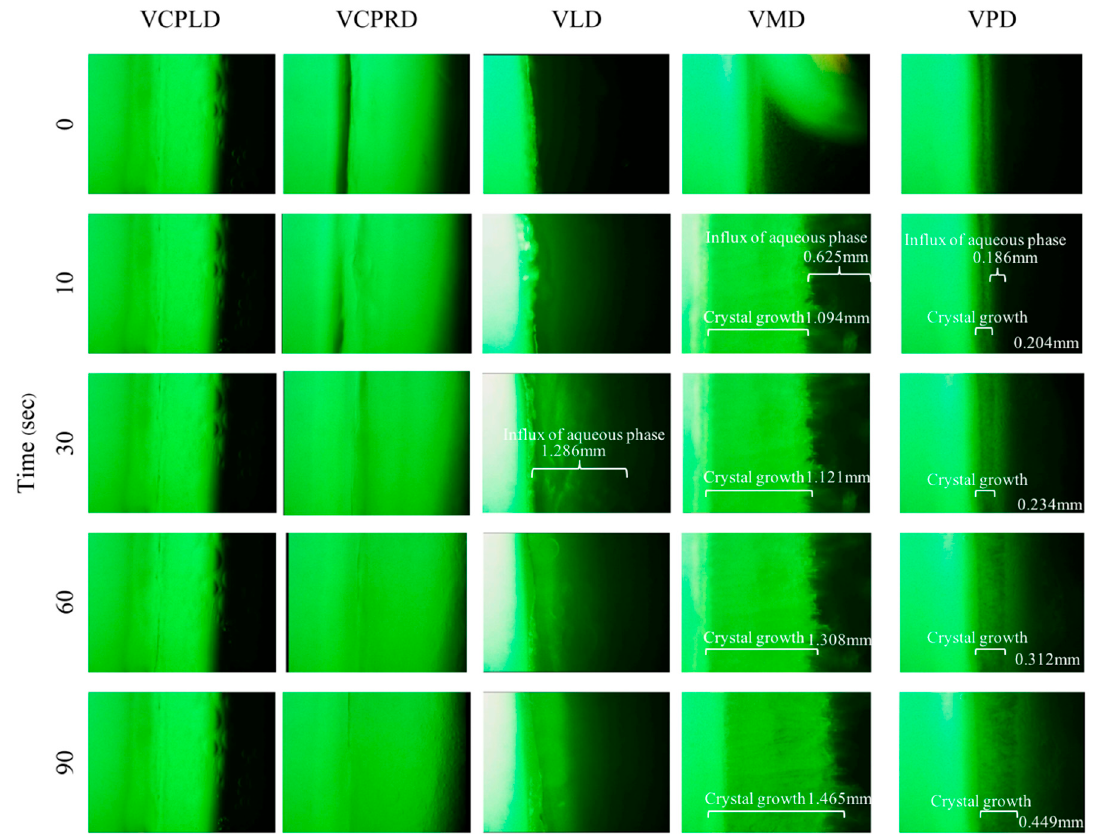
Figure 7. Influx behavior of aqueous phase at boundary of drug-loaded fatty acid in situ forming matrix at 400 × magnification under inverted microscope.